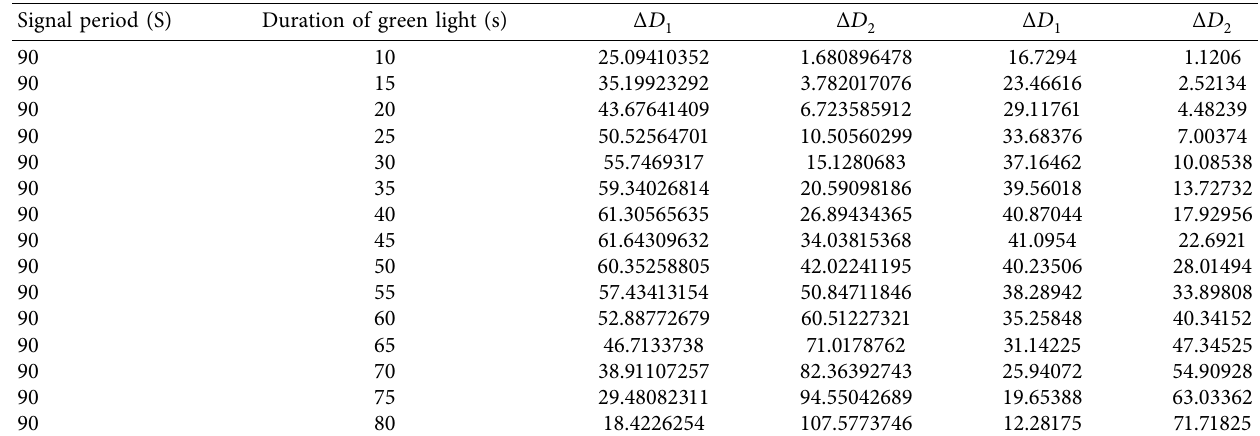
Table 1: Two delay values under different green split.